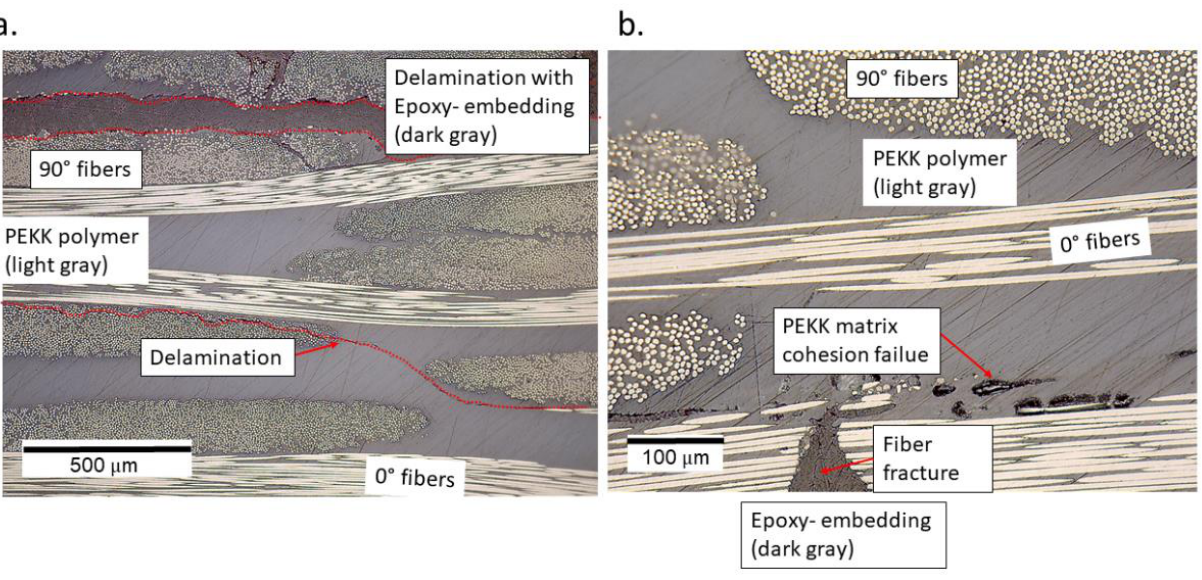
Figure 13. The delamination observed ( a ) in the top layer and ( b ) in the bottom layer of the specimen tested at a cyclic amplitude of 50 μ m and a pause time of 1 s.